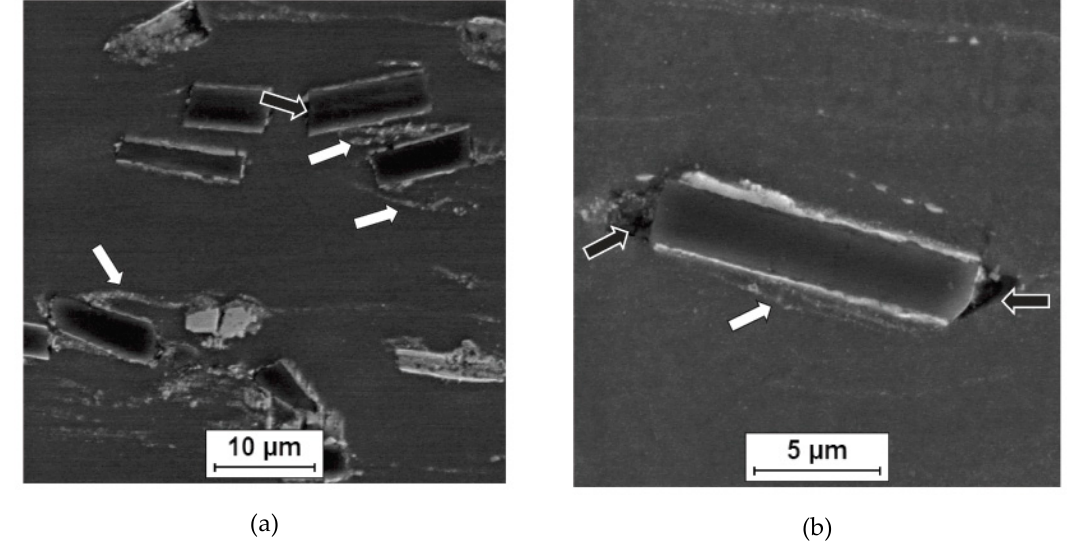
Figure 7. SEM micrographs of Mg-Csf composite KoBo-extruded demonstrated: ( a ) accumulation of intermetallics and oxides bands around (white arrows), ( b ) discontinuities formed between matrix and fiber (black arrows).